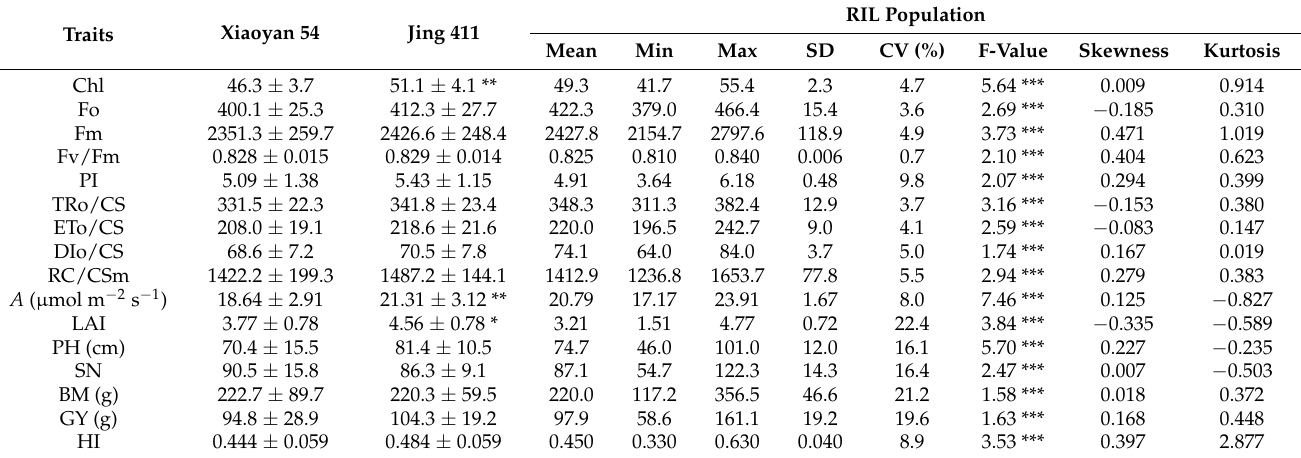
Table 1. Statistics of the investigated traits of the recombinant inbred lines (RILs) and their parents. Traits